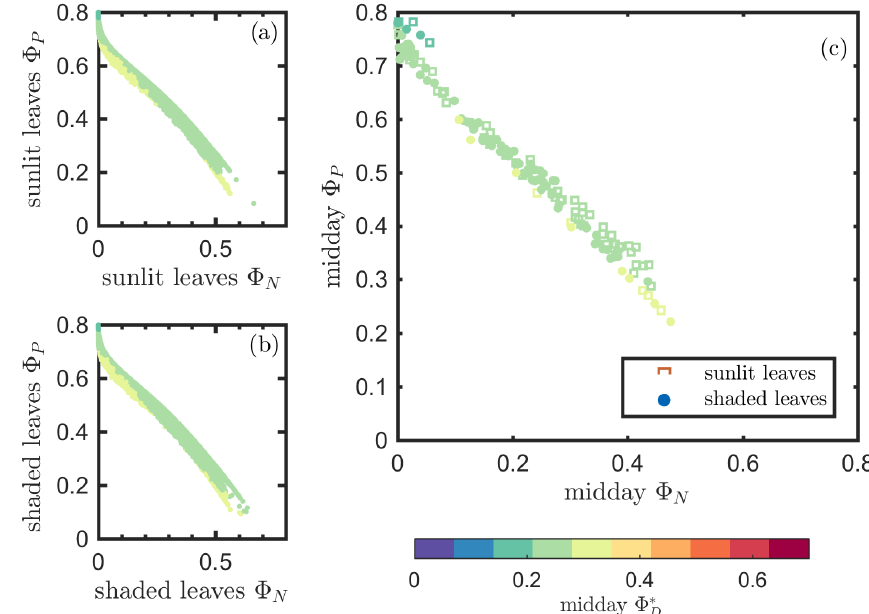
Figure 10. Reproduction of Fig. 7 with simulated variables from the biochemical model of van der Tol et al. (2014).